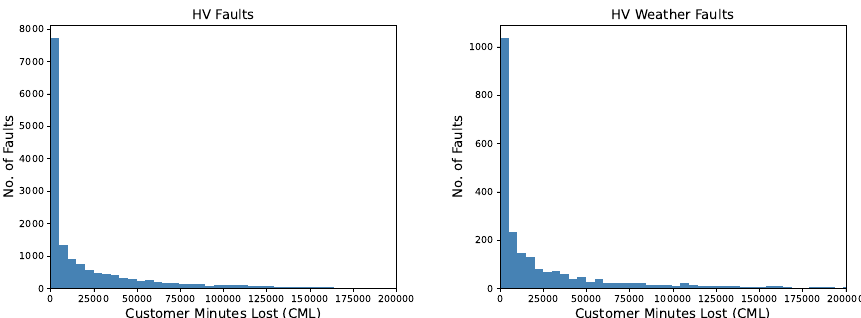
Figure 3. Distribution of the CML that resulted from the HV faults in NPG distribution network licence area ( left : all faults, right : weather related faults).